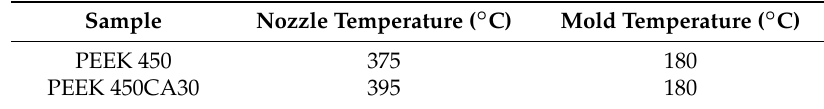
Table 1. The injection molding process of poly-ether-ether-ketone (PEEK) 450 and PEEK 450CA30.